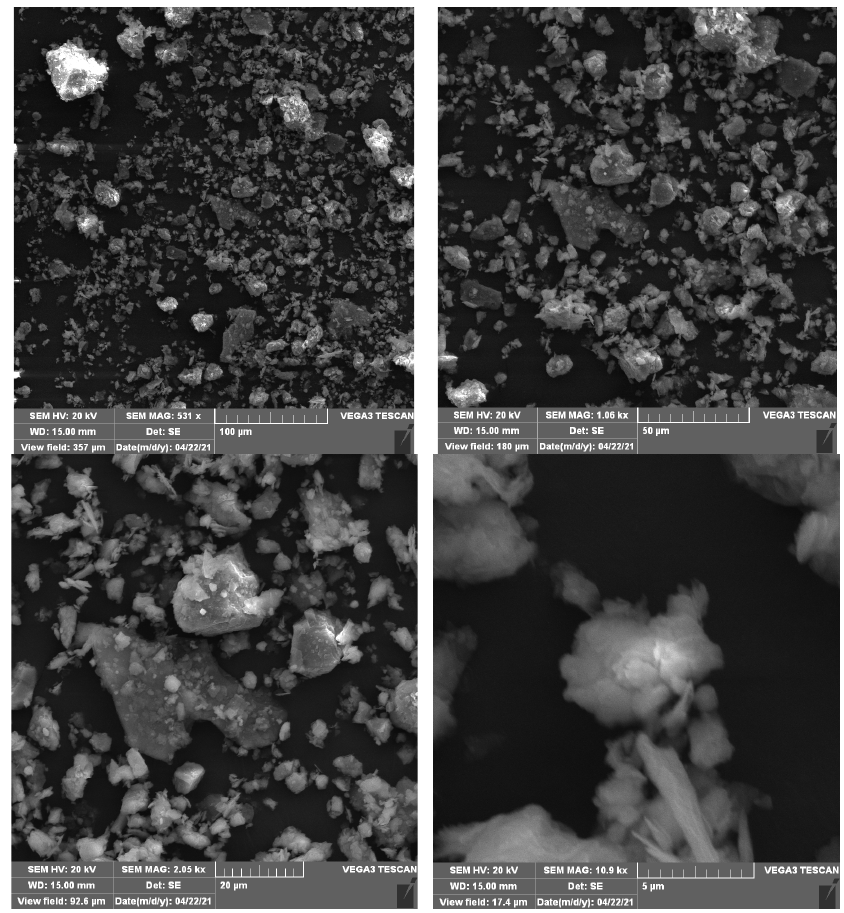
Figure 3. Dardha clay images analyzed by scanning electron microscope (SEM) with resolutions of 100 µm, 50 mm, 20 µm, and 5 µm. Table 2. Physicochemical parameters of natural clays originating from two regions of Albania